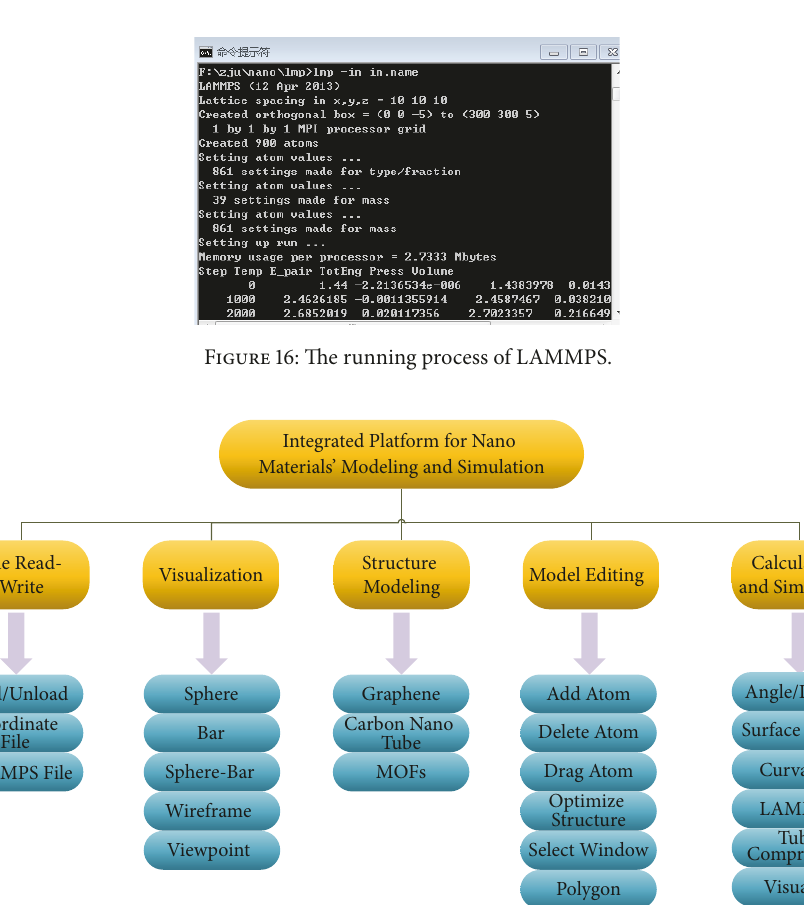
Figure 17: Main functions of the integrated platform.